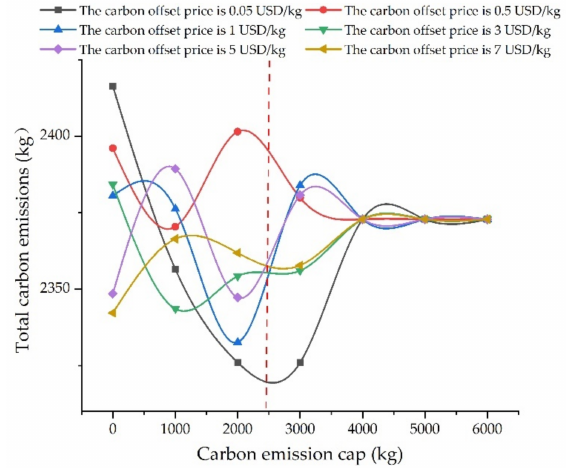
Figure 18. The relationship between total carbon emission and carbon offset price and carbon emission caps in the logistics